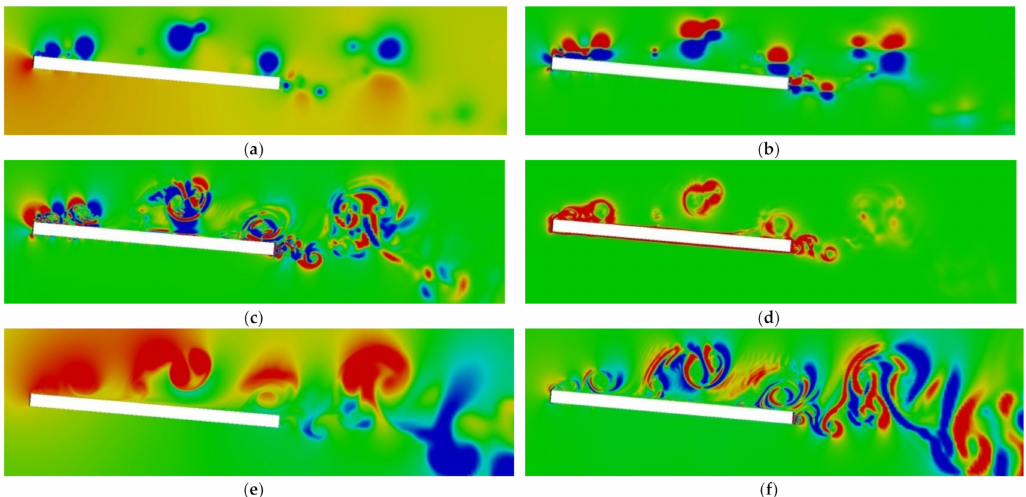
Figure 11. Instantaneous field around a tilted plate moving in strongly stratified fluid, ( T b = 5.25 s, N = 1.2 s − 1 , L = 10 cm, U = 100 cm/s, α = 5 ◦ : fields of pressure ( a ), vertical velocity component ( b ), baroclinic vorticity generation rate ( c ), mechanical energy dissipation rate ( d ), density ( e ), and horizontal component of density gradient ( f ), red and blue colors in the color spectrum correspond to positive and negative values of the perturbation fields, and green color is zero